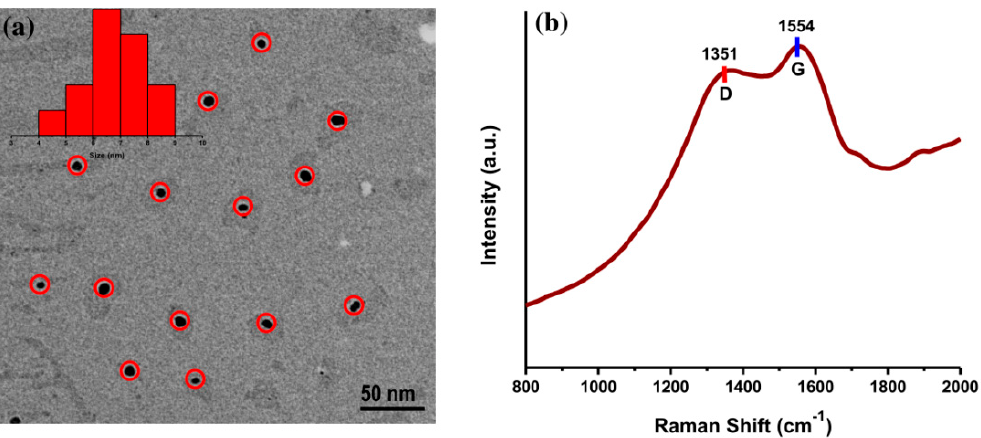
Figure 3. ( a ) Transmission electron microscopy (TEM) image and ( b ) Raman spectrum of AC-NCDs.